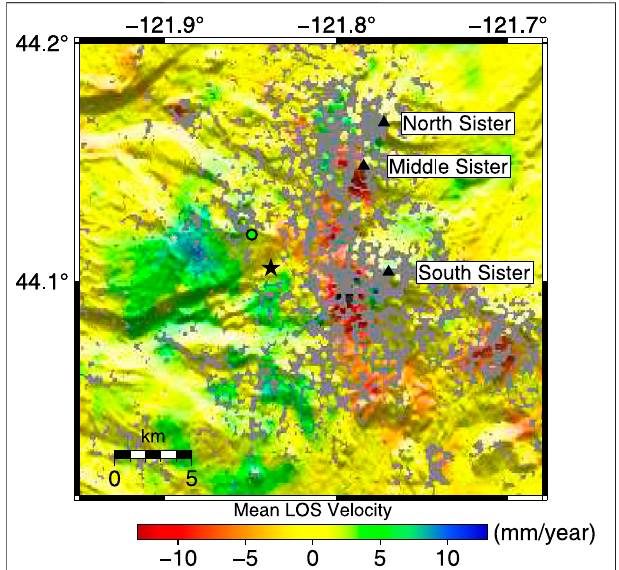
FIGURE 3 | The linear surface deformation LOS velocity (mm/year) obtained for the ascending Path 219 ALOS-1, using the small baselines method implemented in StaMPS (Hooper et al., 2012) for the period January 2007 to March 2011. Positive LOS velocity values corresponds to displacements toward the satellite, i. e., uplifting. Black triangles and star represent the Three Sister complex volcano system and the approximate center of the uplifting area. StaMPS LOS velocity results were noisy and we post-processed to reduce undesirable oscillations of non-volcanic origin. We applied abandpass fi ltertoretainspatialdeformationsignalsbetween10and 0.8 km using a median fi lter (GMT blockmedian). Results indicate a 6 km circular uplift pattern west of South Sister with a mean LOS velocity of approximately 5 – 10 mm/year, consistent with a value obtained for the Husband CGPS station during the same period (5.21 mm/year), shown as circle with a black